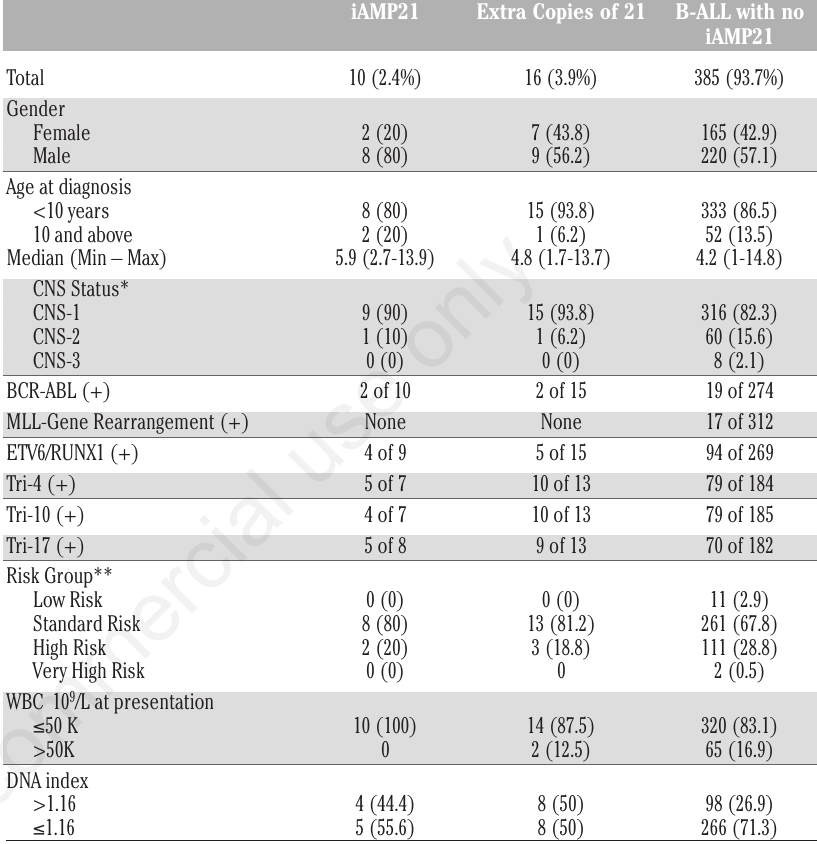
Table 1. Patients characteristics at the time of diagnosis with CNS status on D14 of induction chemotherapy; n=411 (%)